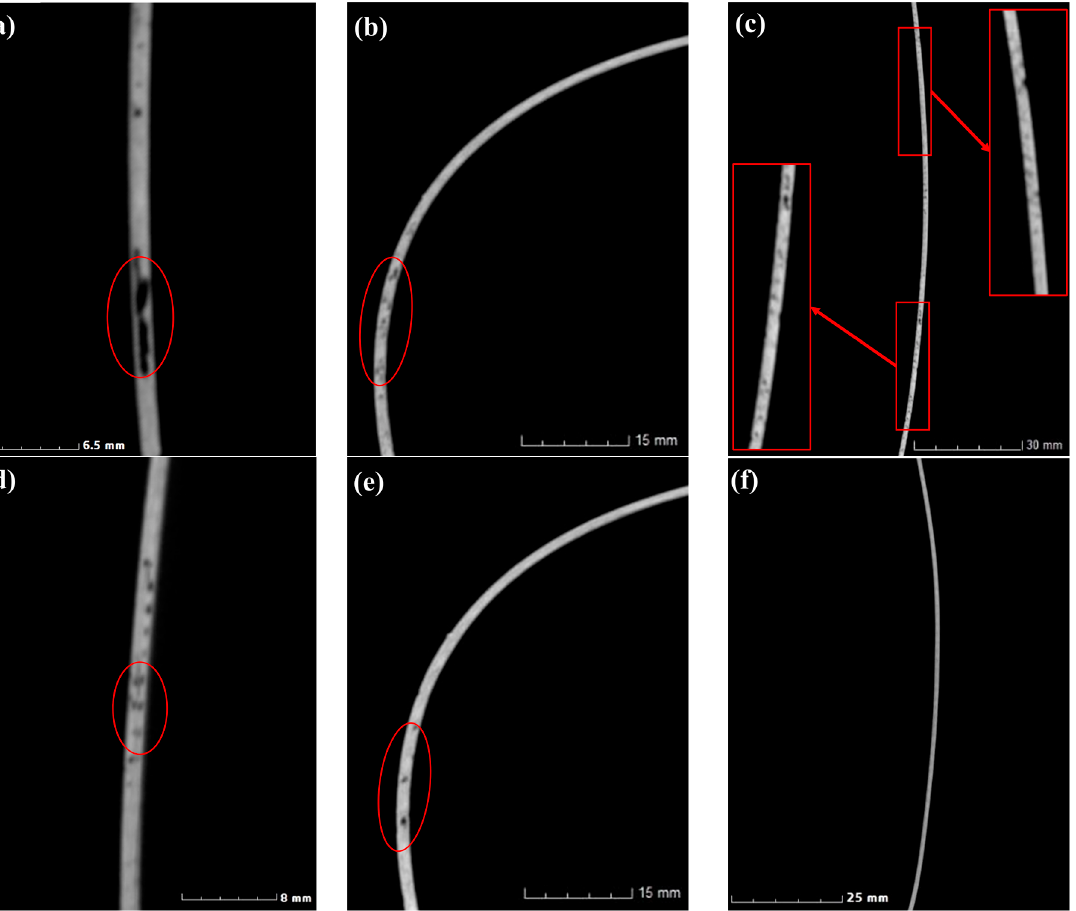
Figure 7. Void characterization of cross-section for helmet shell: ( a – c ) helmet prepared using RTM process; ( d – f ) helmet prepared using M-CRTM process.